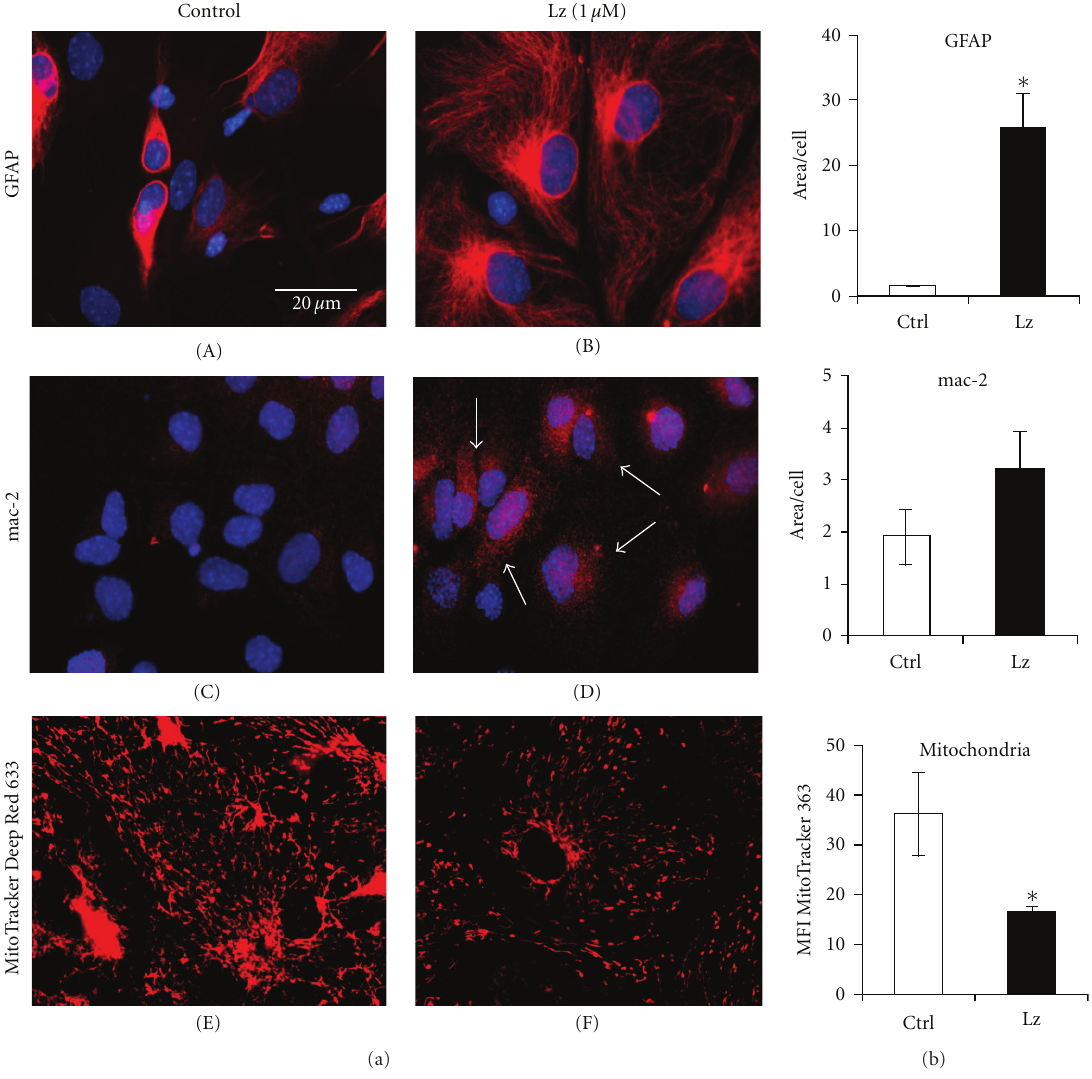
Figure 4: Immunocytochemical assessment of neuronal and glial status in primary hippocampal cultures treated with letrozole . Primary dissociated hippocampal cultures were treated with letrozole (1 μ M, 24hrs), following which immunocytochemical analysis was performed for cell-specific markers. (a) Neurons ((A) and (B)) were stained with antibodies against beta III tubulin (1: 100), astrocytes ((C) and (D)) with anti-GFAP (1: 500), and microglia ((E) and (F)) with anti-Mac-2 (1:350). Note the marked astrocyte hypertrophy in letrozole-treated cells. Arrowheads indicate enlargement of the neuronal processes following Lz treatment. Arrows in (F) outline activated microglia, which exhibit increased mac-2 staining. ((G) and (H)) MitoTracker Deep Red 633 staining revealed truncated mitochondria in Lz-treated cells compared with control, indicative of increased mitochondrial fission and potentially mitochondrial dysfunction. Scale bar (20 μ m) in first panel is representative for all panels. (b) Quantification of stained area per cell for neurons ( β III -tubulin), astrocytes (GFAP), and microglia (mac-2) following letrozole